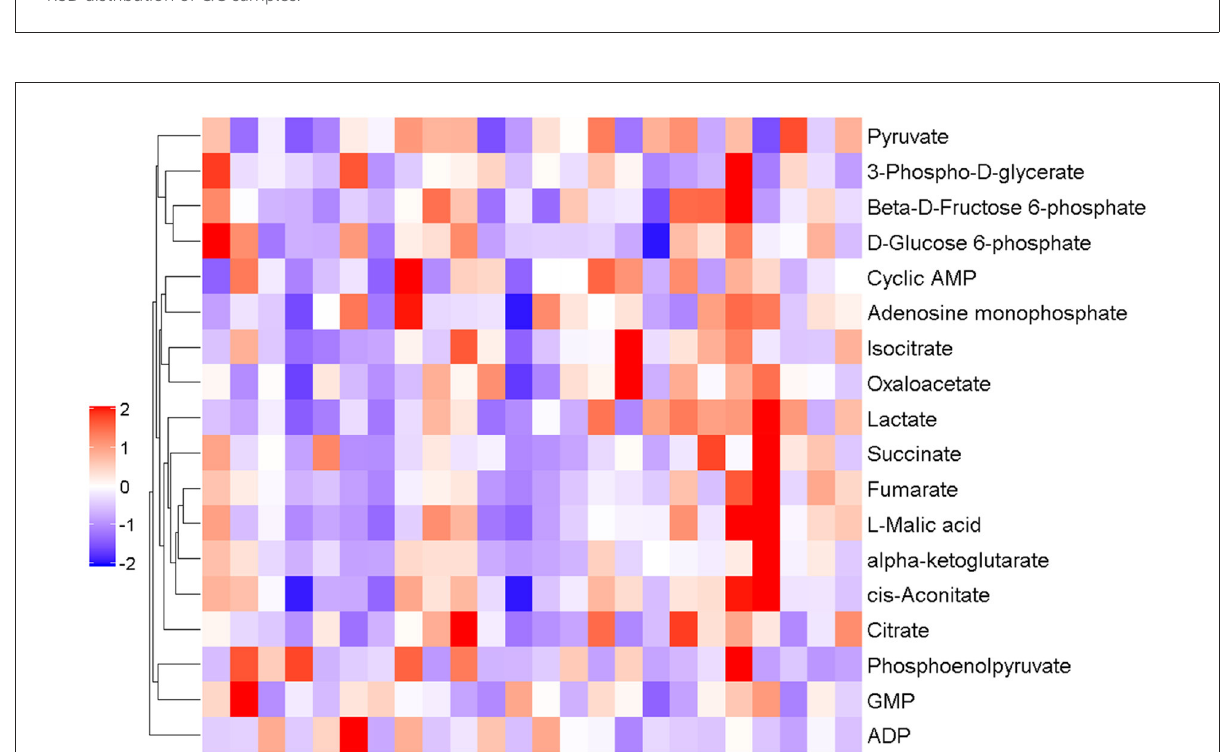
FIGURE9 Results of hierarchical metabolite clustering at 50min post-test. The horizontal coordinate indicates the sample and the vertical coordinate the intensity of metabolite expression; red indicates a positive correlation, purple indicates a negative correlation, and the darker color indicates higher metabolite